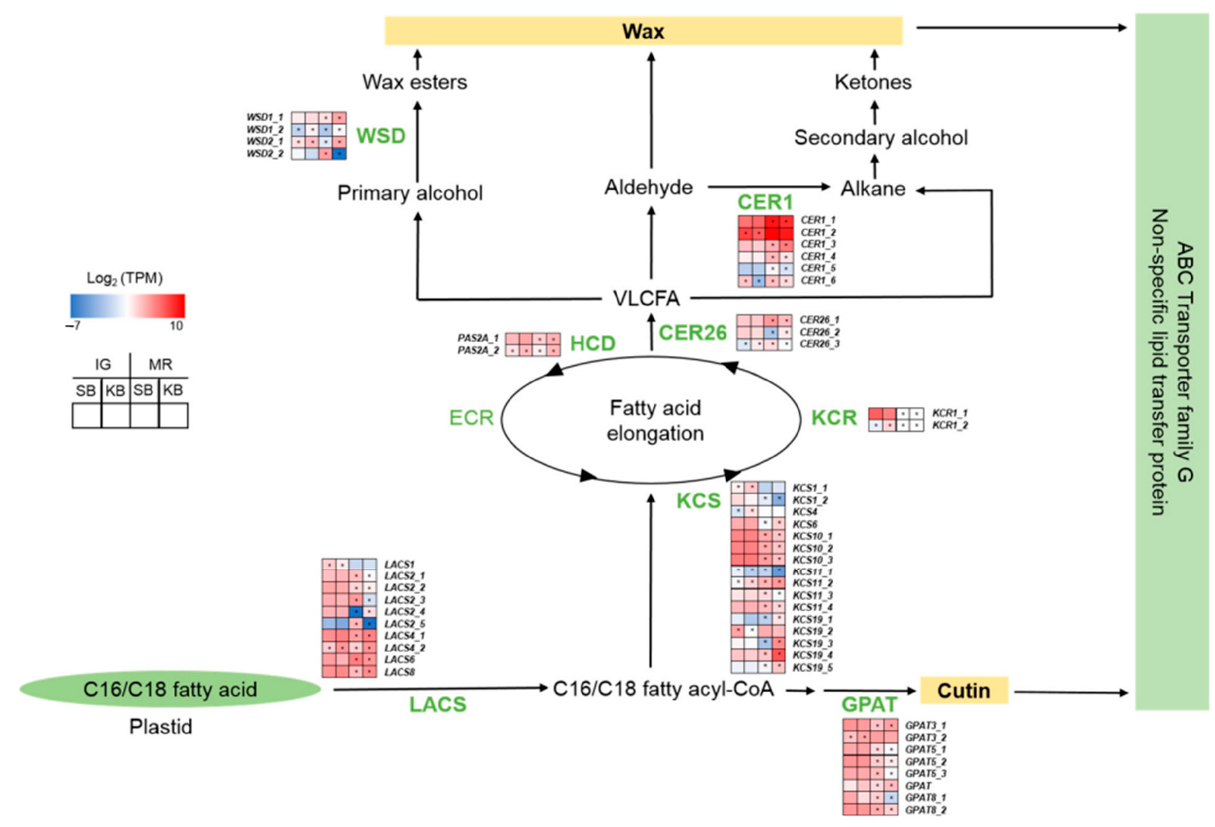
Figure 4. Expression patterns of cuticle biosynthesis genes at IG and MR in “Sunnyberry” and “Kingsberry” strawberry fruit. CER, protein ECERIFERUM; ECR, enoyl-CoA reductase; GPAT, glycerol-3-phosphate acyltransferase; HCD, 3-hydroxyacyl- CoA dehydratase; IG, immature-green; KB, “Kingsberry” cultivar; KCR, 3-ketoacyl-CoA reductase; KCS, 3-ketoacyl-CoA synthase; LACS, long-chain acyl-CoA synthetase; MR, mature-red; PAS2A, very-long-chain (3R)-3-hydroxyacyl-CoA dehy- dratase PASTICCINO 2A; SB, “Sunnyberry” cultivar; TPM, transcripts per million; WSD, wax ester synthase/diacylglycerol O -acyltransferase. Asterisks indicate statistically significant differences between cultivars (FDR p < 0.01; |Fold change| >